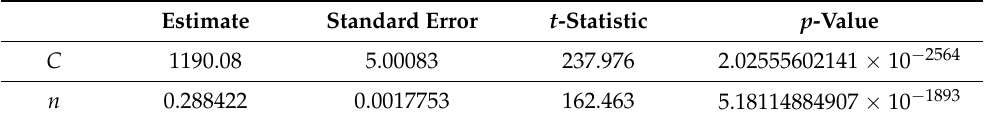
Table 10. Results from regression analysis for Swift’s model.